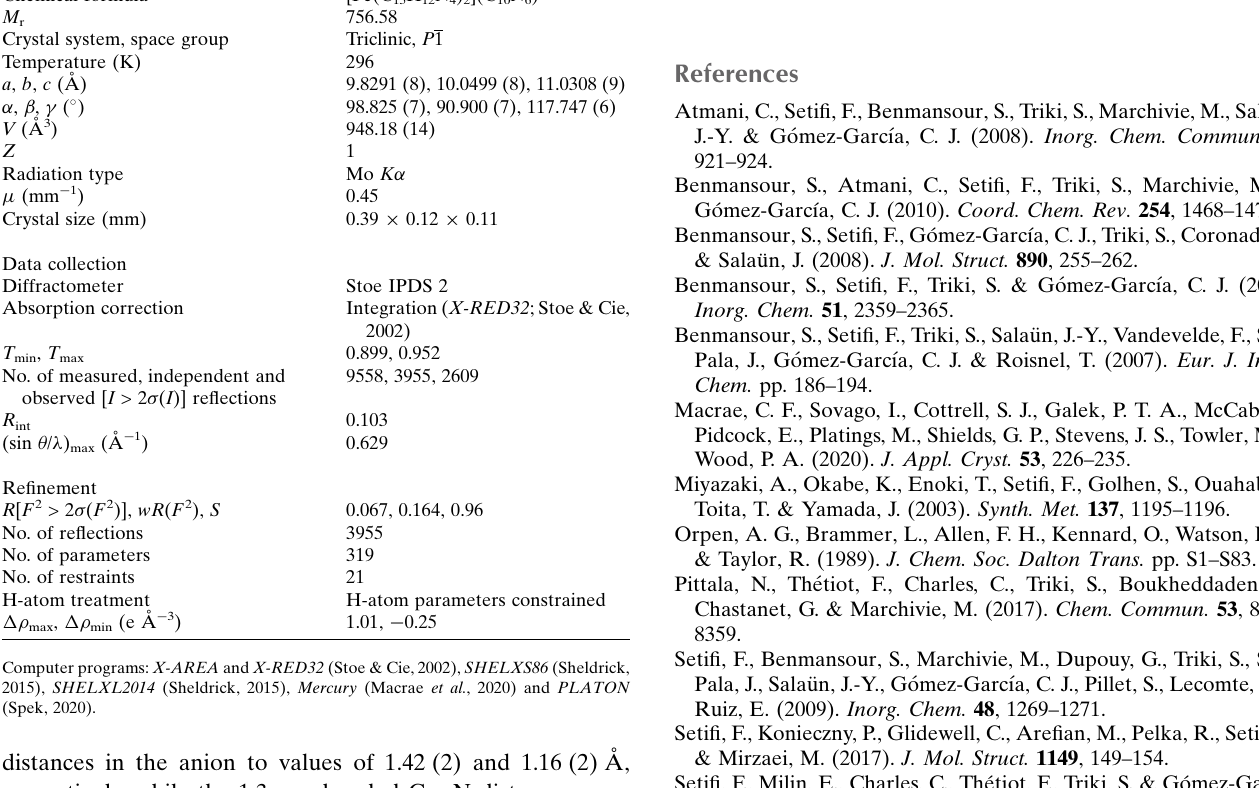
Table 2 Experimental details. Crystal data Chemical